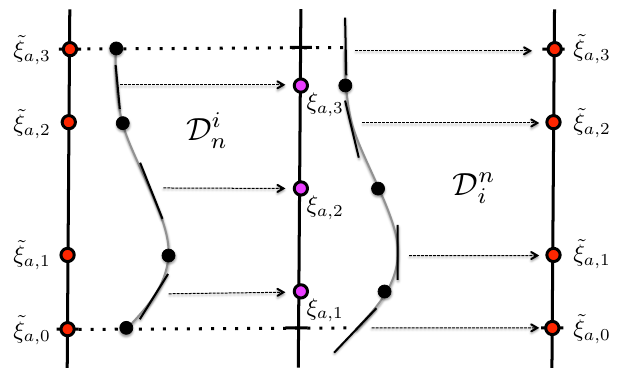
Figure 2. A depiction of the derivative operators D i n and D n remap from interfaces to levels and levels to interfaces, respectively. The gray line depicts a typical field variable within element a that emerges from the expansion (left) (Eq. 24) or (center) (Eq.